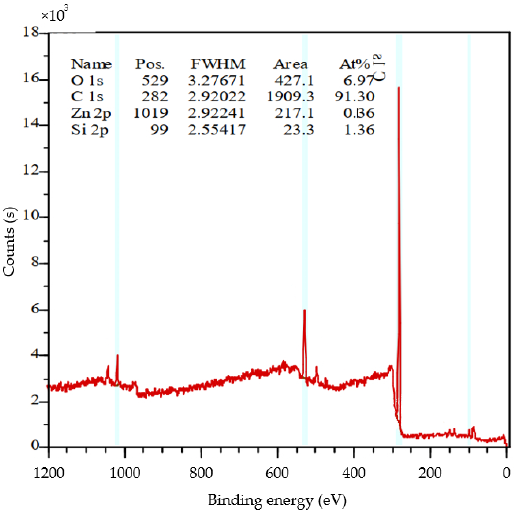
Figure 5. The XPS spectrum of the crumb rubber sample with 30 mesh.